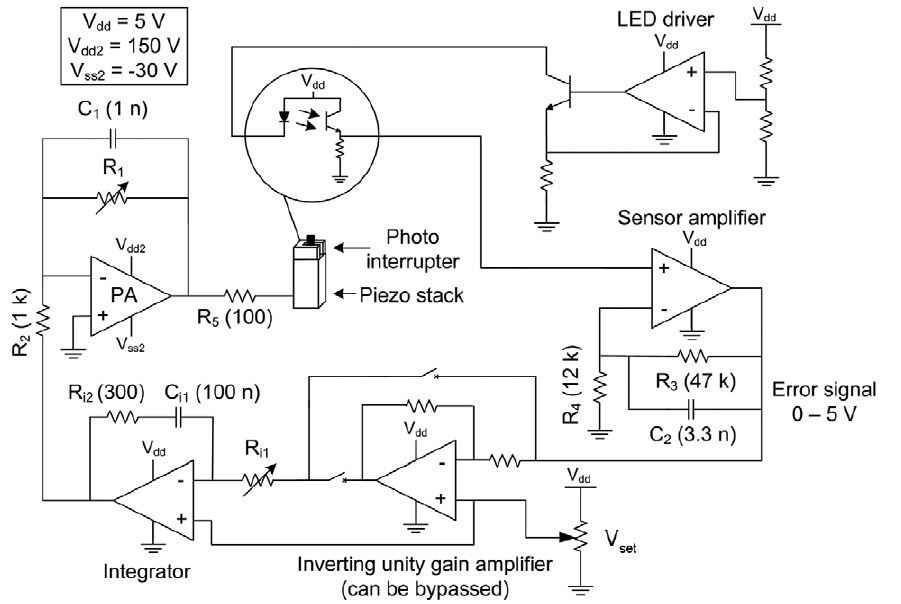
Figure 2. Schematics of one axis of the stabilization system electronics. PA = power amplifier; V set is a parameter used to match the control loop DC level with that of the sensor output.